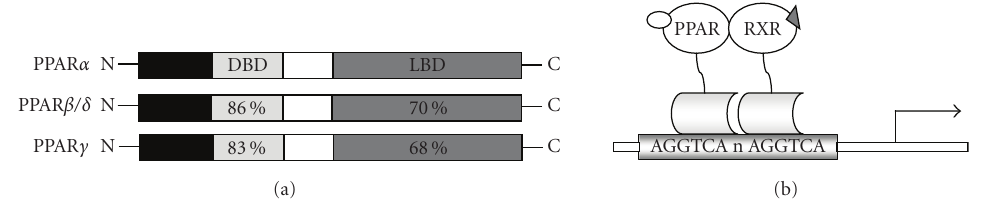
Figure 1: (a) Functional domains of PPAR isoforms. N, N-terminus; DBD: DNA-binding domain; LBD: ligand-binding domain. The numbers represent percentage identity to human PPAR α . (b) PPAR/RXR binds to PPREDR-1 promoter regions. Binding of agonists leads to heterodimerization, recruitment of coactivator and transcriptional activation of target